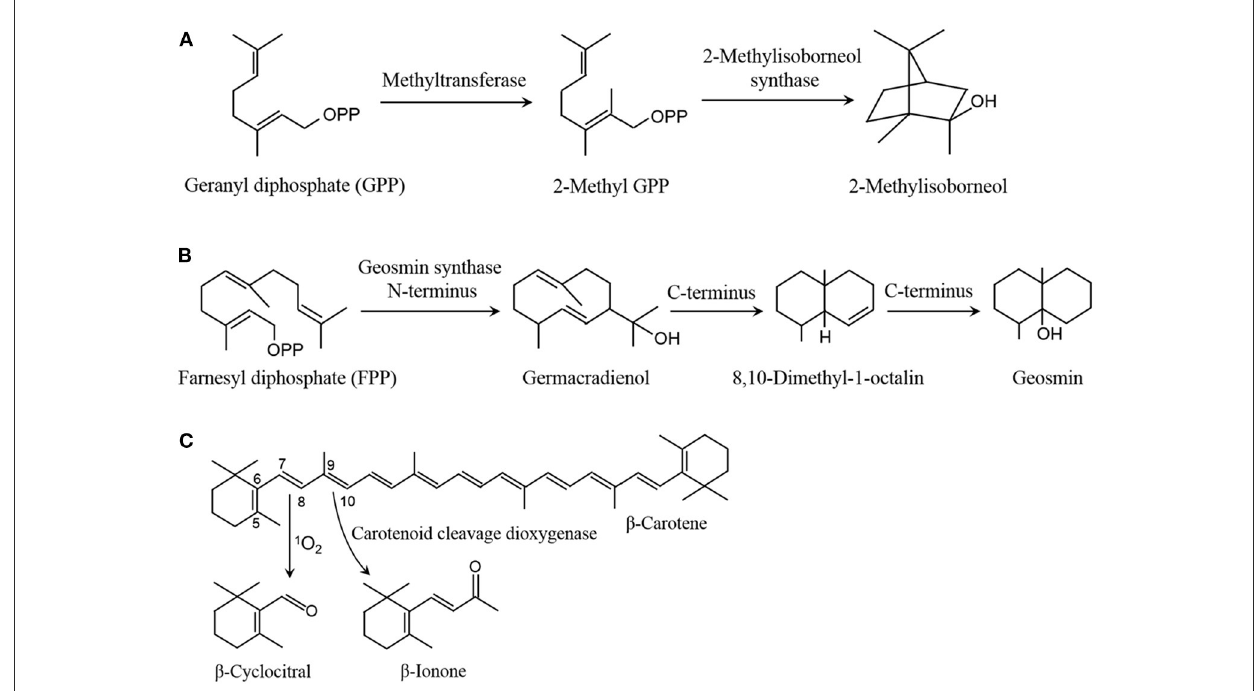
FIGURE1 Pathway of 2-methylisoborneol (A) , geosmin (B) , β -cyclocitral and β -ionone (C)